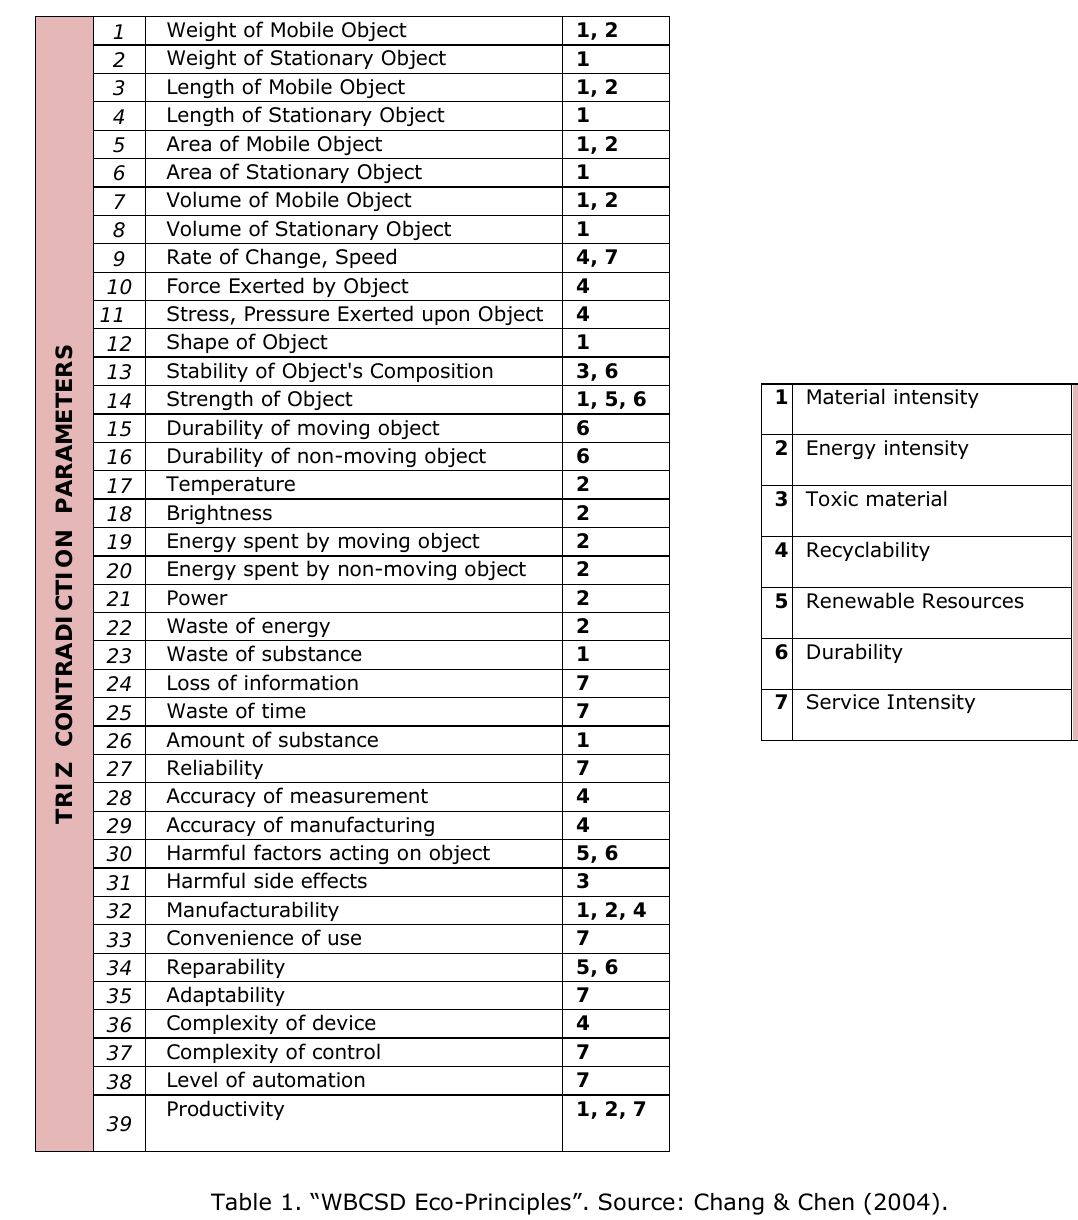
Table 1. “WBCSD Eco-Principles”. Source: Chang & Chen